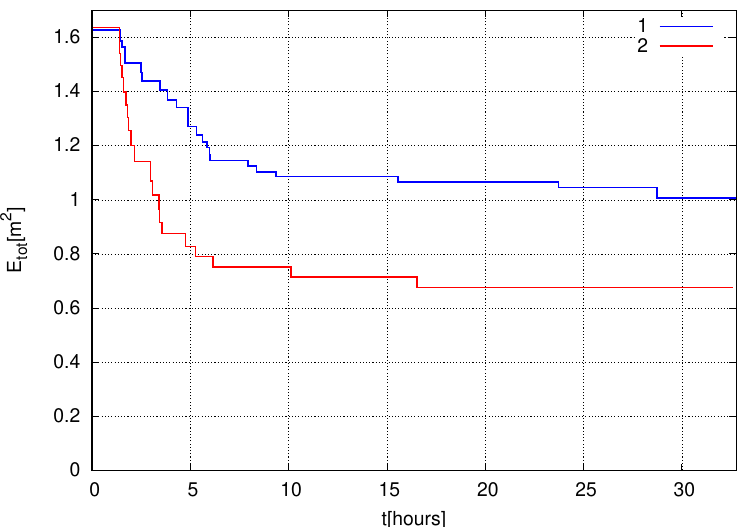
Figure 19. Dependence of the total energy E tot on simulation time for numerical experiments with µ = 0.08 and ˜ k p = 1 in different models. The blue solid line 1 corresponds to the SCZ equation and the red solid line 3 to the RV